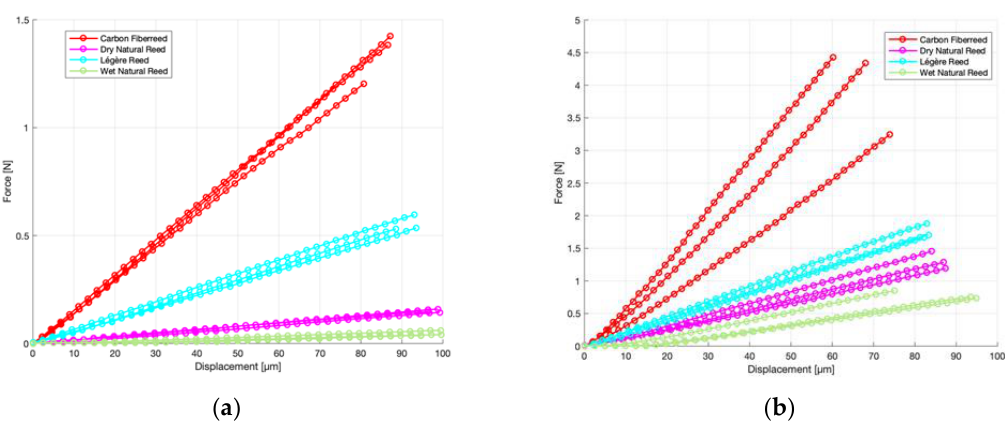
Figure 4. ( a ) Force–displacement curves of different reed materials in transversal direction. ( b ) Force–displacement curves of different reed materials in longitudinal direction.